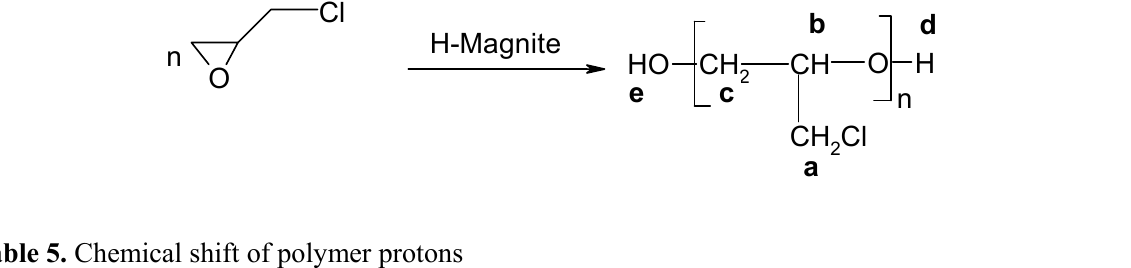
Table 5. Chemical shift of polymer protons Proton type